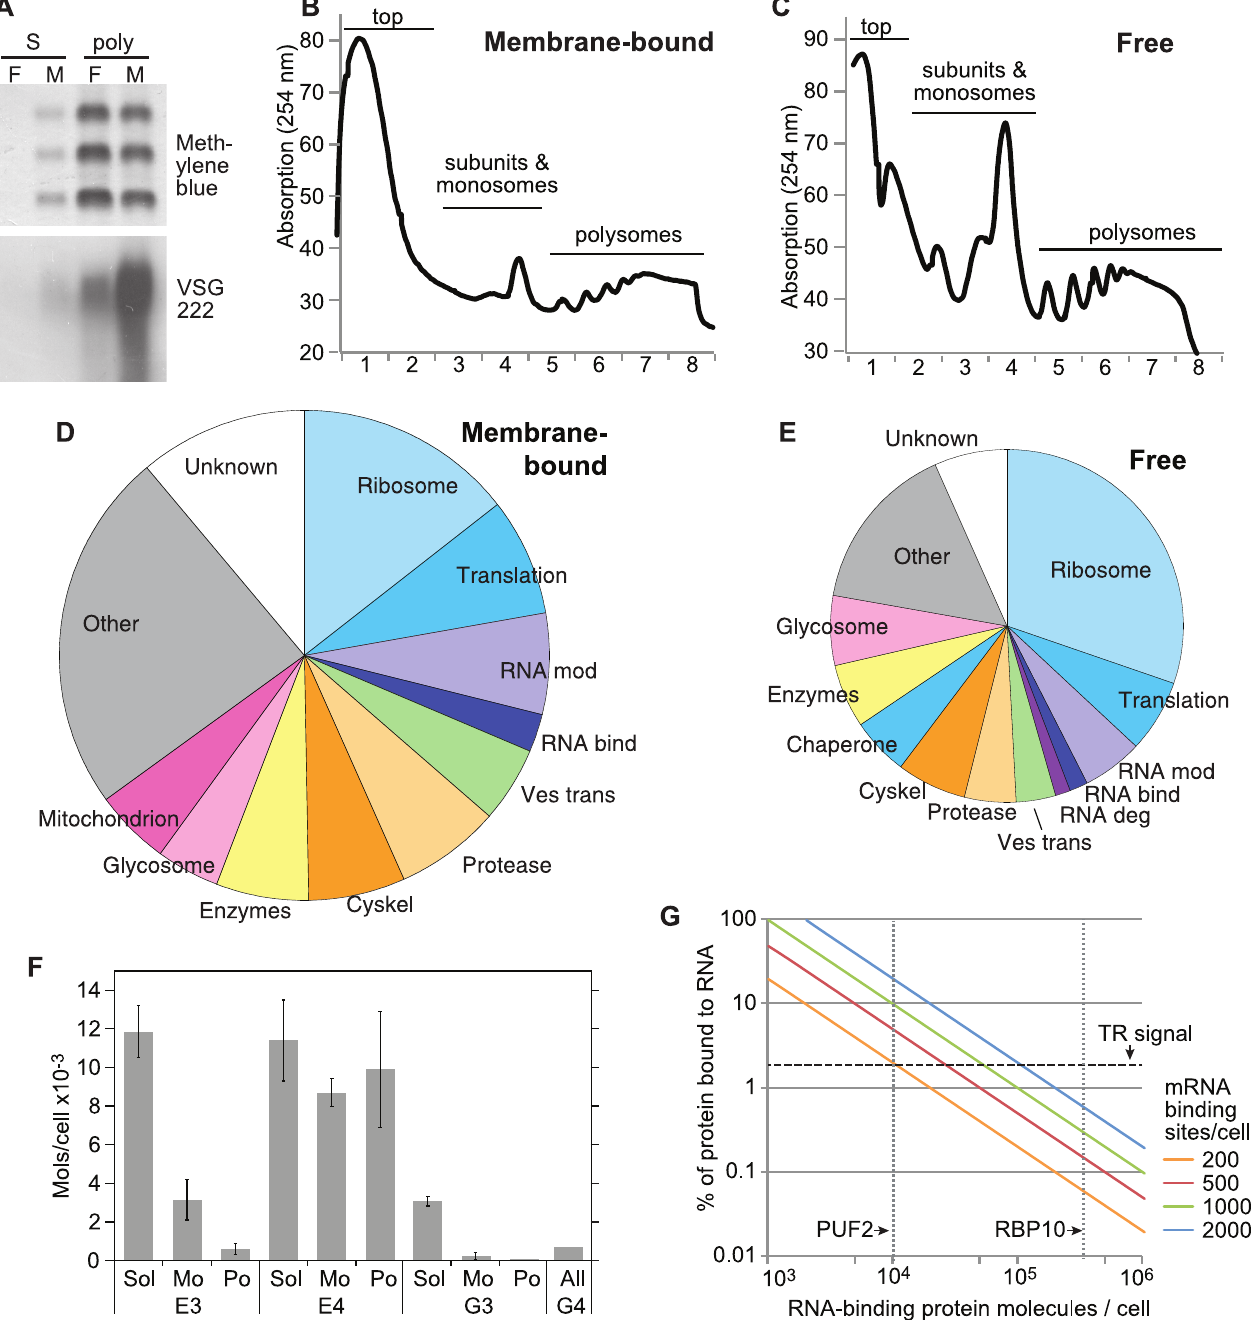
Fig 1. Association of EIF4E complexes with polysomes. A: Northern blot probed against the VSG mRNA with bloodstream-form samples made from the soluble protein peak (S) and the polyribosomes (poly) from the gradients shown in panel B (free, F) and panel C (membrane-bound, M), in order to show the proper separation of free and membrane-bound polyribosomes. B: Absorption at 254nm after sucrose gradient fractionation of a typical membrane-bound fraction from bloodstream-form trypanosomes. C: Absorption at 254nm after sucrose gradient fractionation of a typical free fraction from bloodstream-form trypanosomes. D,E Pie charts illustrating the protein functional classes in polysomal fractions in membrane-bound (D) and free polysomes (E). Results are pooled from bloodstream-form and procyclic-form parasites. All proteins were manually classified; see S3 Table for details. These diagrams show the results for 523 proteins, chosen using a threshold of > 97.5% confidence and at least 2 peptides; to calculate the class enrichment, we used a unique gene list which includes only on representative of repeated genes (S3 Table sheet 2). The eleven most abundant categories are illustrated for each preparation; with the remainder grouped as "Other". Categories present in both preparations have the same colour code, and the areas of the circles are proportional to the total numbers of proteins identified. Ribosome: ribosomal proteins; Translation: translation factors and amino-acyl tRNA synthetases; RNA mod; RNA